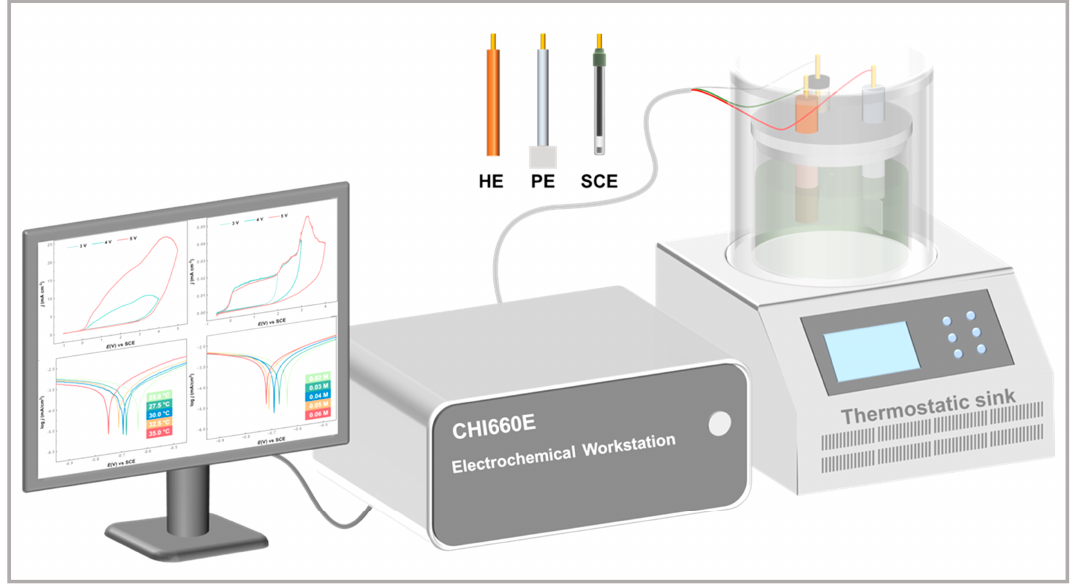
Figure 2. Schematic diagram of the electrochemical measurement equipment for the three-electrode system of the anodic Hf corrosion/dissolution in the EHS system. Working, auxiliary and reference electrodes are hafnium electrode (HE), platinum electrode (PE) and saturated calomel electrode (SCE), respectively.